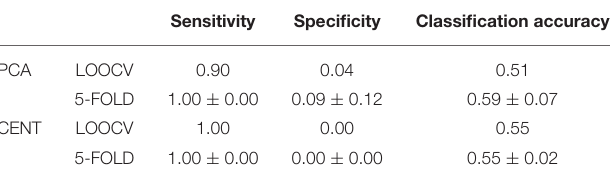
TABLE 5 | Same as in table 4 but for ML-FCG iPLV .